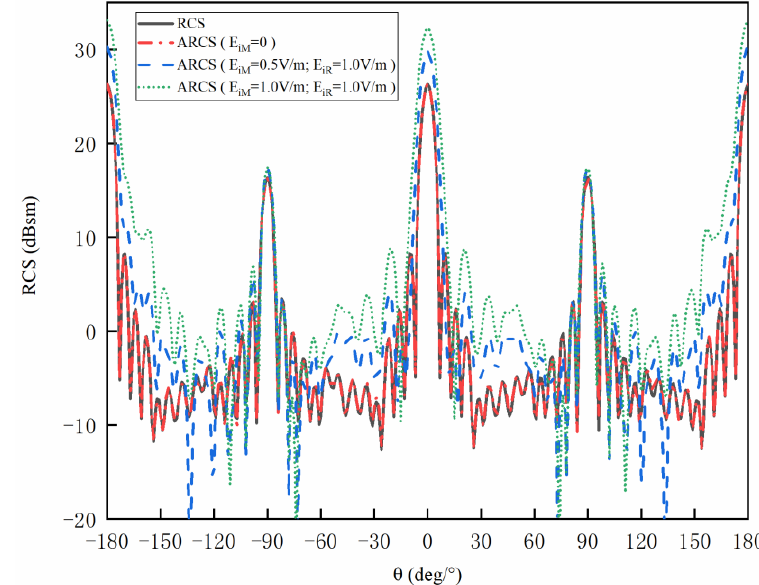
Figure 7. The RCS and ARCS with different E iM of the metal cylinder structure.